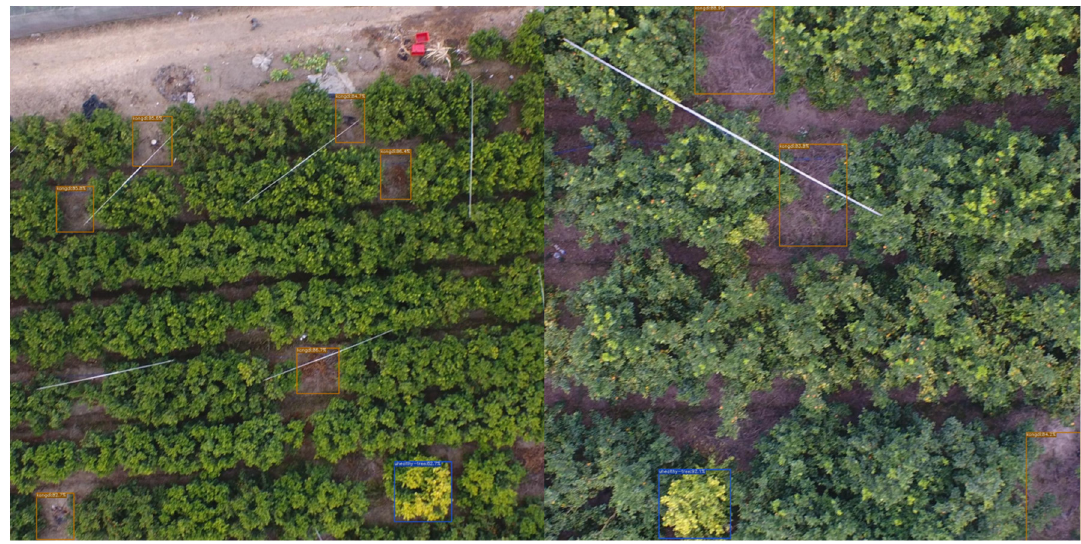
Figure 10. The effect of the UAV patrol orchard. orange box indicates uneven planting or felled areas, blue box indicates yellow suspected disease plants.